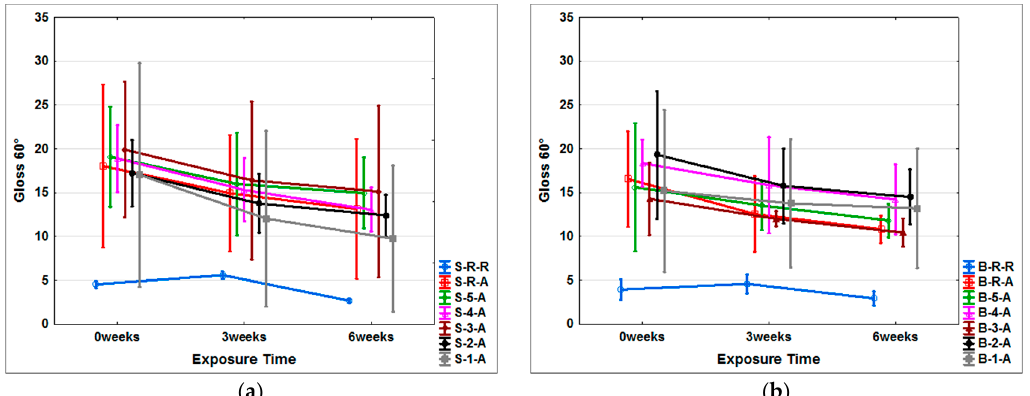
Figure 4. Gloss changes in tested wooden surfaces during AW: ( a ) Gloss changes on tested spruce samples; ( b ) Gloss changes on tested beech samples.